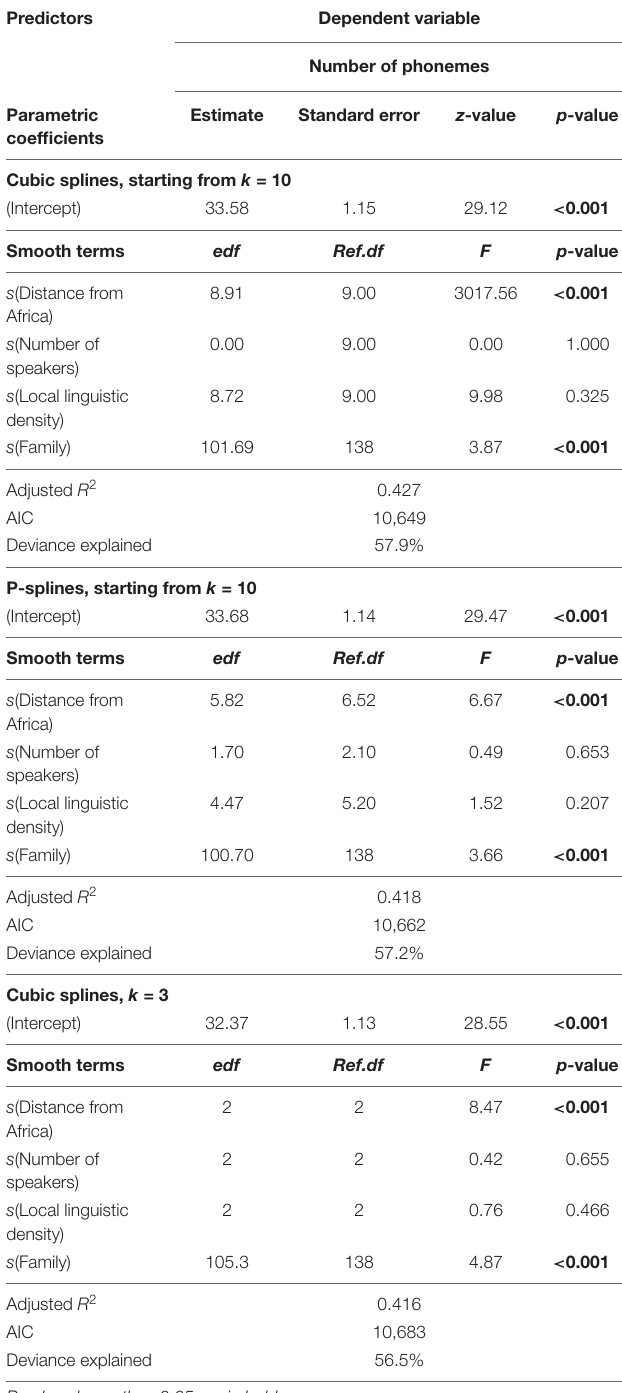
TABLE 4 | Output of three inverse-Gaussian GAMM: with cubic splines for continuous predictors (top), with P-splines (middle), with cubic splines and a smoothing parameter fixed to 3 (bottom); in all models, a random effect smoother is applied to the predictor Family